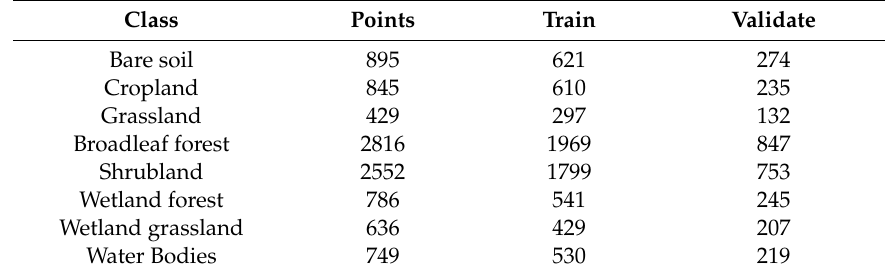
Table 2. Visually interpreted points used to train the random forest classifier and validate the resulting land cover map using the international geosphere biosphere programme (IGBP) classes. Class Points Train Validate Bare soil 274